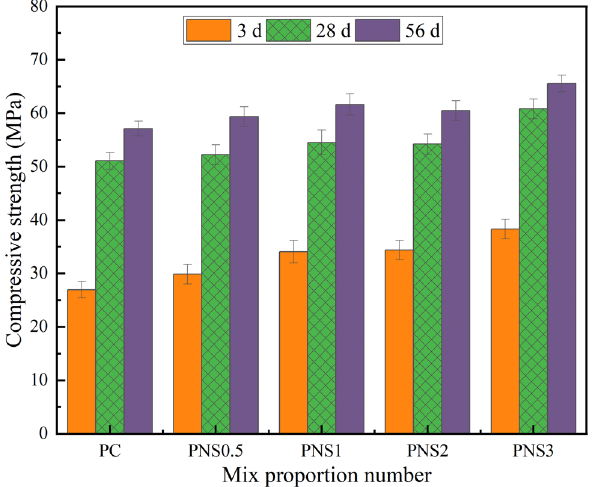
Figure 2: E ff ect of the content of nano - SiO 2 on the compressive strength [ 79 ] .